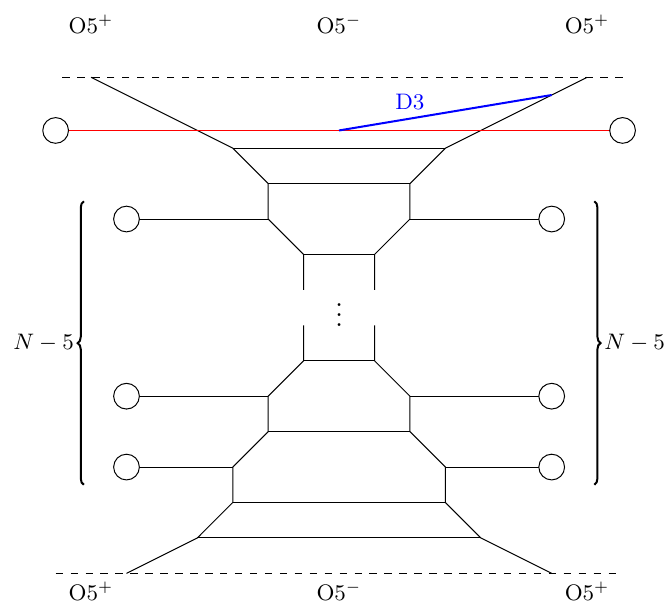
Figure 8. 5-brane web for SO(2 N − 2) gauge theory with N f = 2 N − 10 fundamental flavors and a codimension 2 defect. The defect is realized via a D3-brane which is suspended between the 5-brane web for SO(2 N − 2) and a D5-brane that moves away along the Higgs